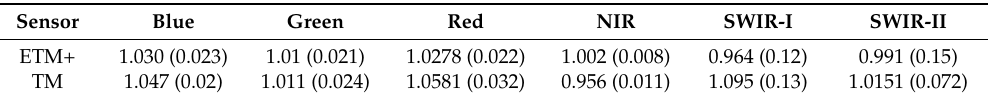
Table 2. The vicarious gains for the ETM+ and TM bands. One-standard deviations are presented in round brackets. Note that these gains are derived from the NIR-SWIR-I band combination. The gains for these two bands are derived in step